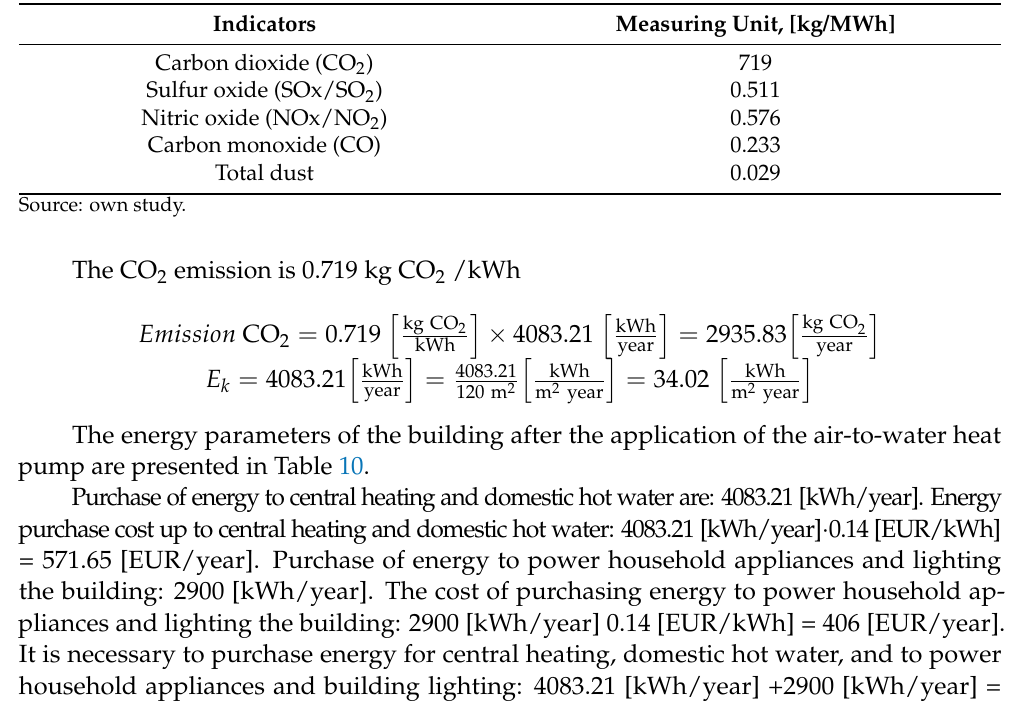
Table 9. Heating system air-to-water heat